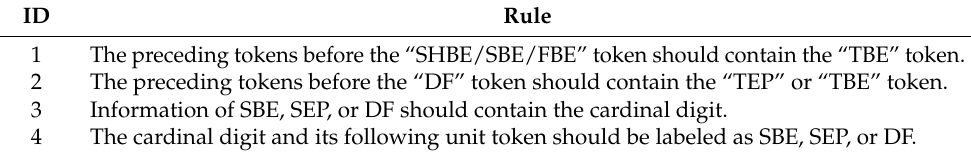
Table 2. Formalized sequence labeling